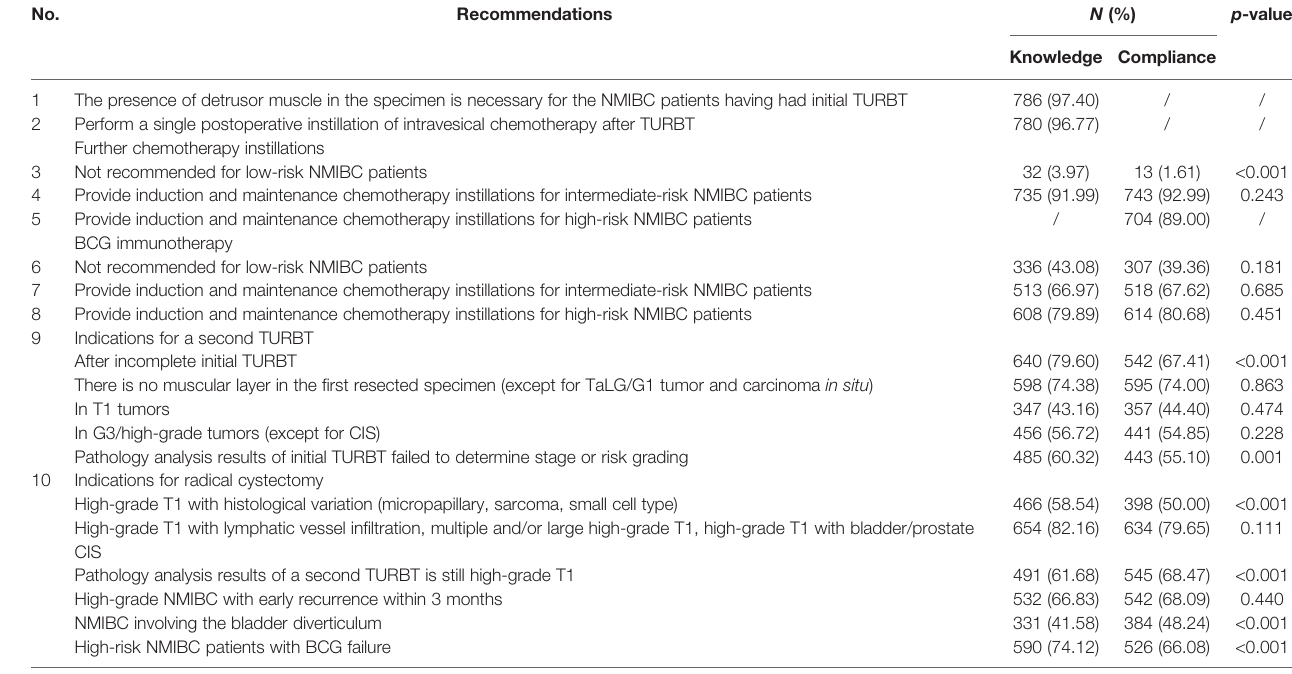
TABLE 2 | Knowledge of and compliance with guideline